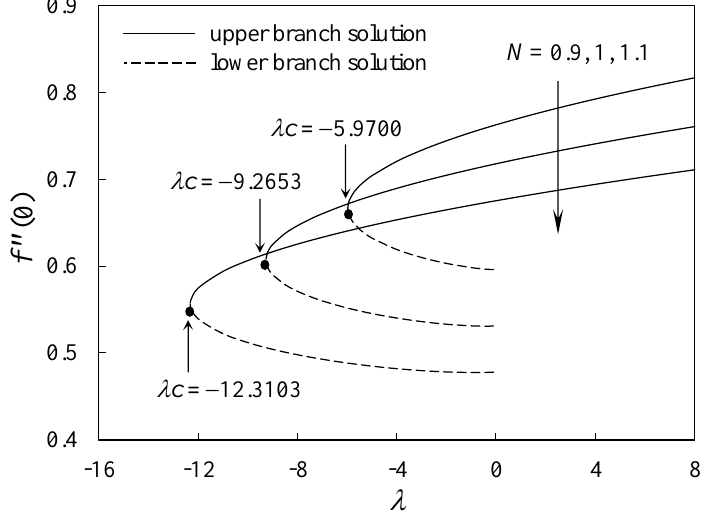
  0 f  Figure 2. Variation of f (cid:48)(cid:48) ( 0 ) with λ for several values of N for Cu-water Figure 2. Variation of with  for several values of N for Cu-water nanofluid.